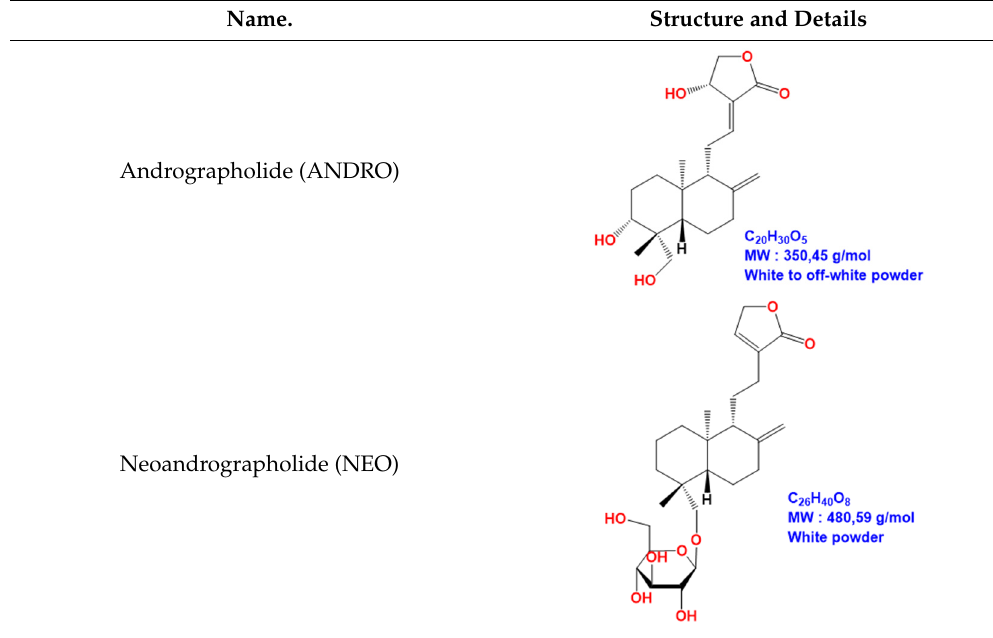
Table 1. Structure of ANDRO, NEO, 14DAP and 14DAP11 ‐ 12. Name.